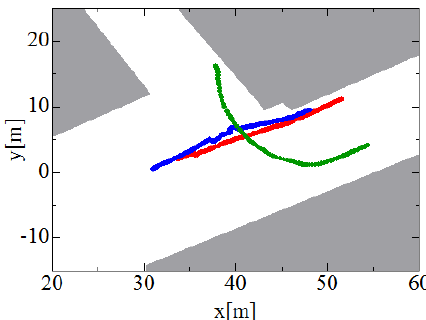
Figure 12. Pedestrian tracks estimated by individual and cooperative tracking. Red, blue and green lines indicate paths of pedestrians #1, #2 and #3,